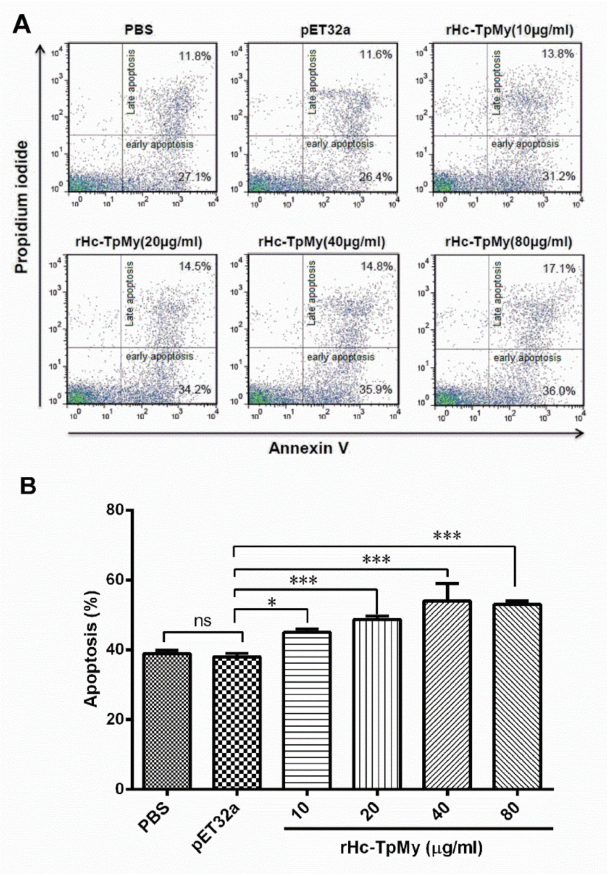
Figure 7. Apoptosis of goat PBMCs in respond to rHc-TpMy. (A) Apoptosis of PBMCs was determined by flow cytometry followed by staining with annexin V and PI. The percentages of cells with di ff erent staining patterns are shown. (B) rHc-TpMy increased apoptosis of goat PBMCs. The results are representative of three independent experiments. Data are presented as the mean ± SD (n = 3); an asterisk indicate treatment groups di ff er significantly (* p < 0.05) and highly significantly (*** p < 0.001) to that of control